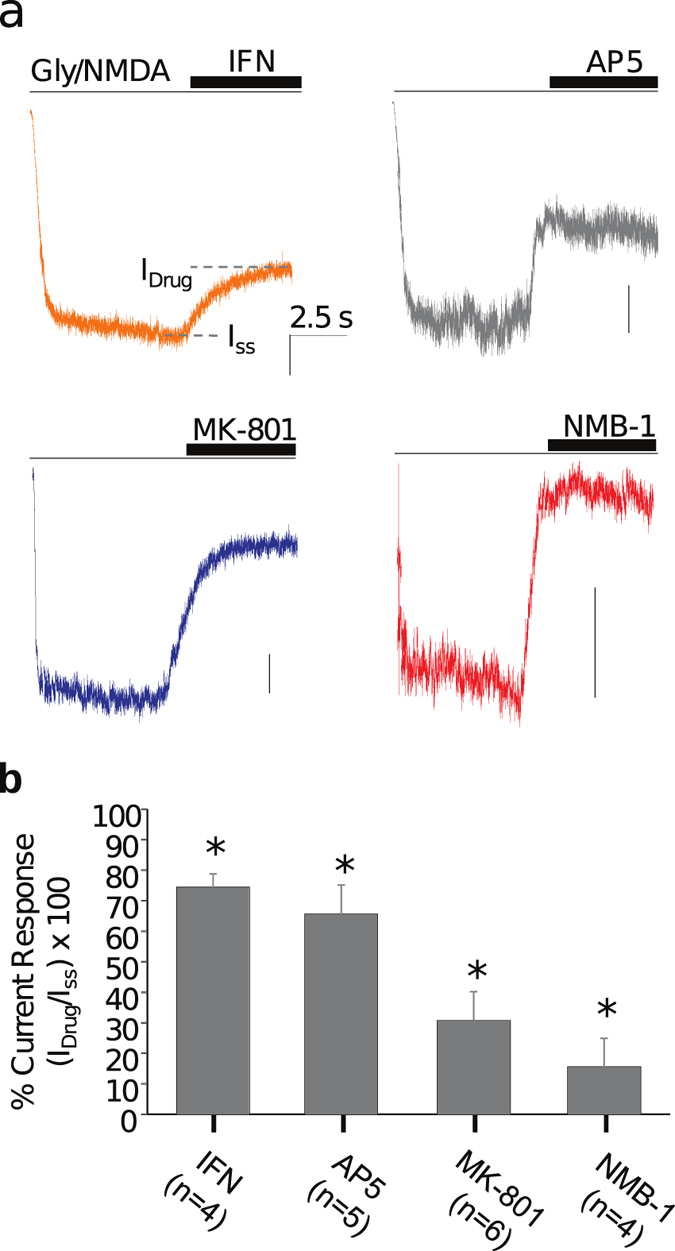
Pharmacological inhibition of NMDA-evoked currents in cultured astrocytes.(a) Representative whole-cell currents evoked by co-application of NMDA (100 μM) and glycine (100 μM); drugs were applied for 5 s to reach steady-state (Iss). Vertical scale bars represent 100 pA. (b) Summary of current blockage by IFN (10 μm, N = 4), AP5 (100 μM, N = 5), MK-801 (50 μM, N = 6), and NMB-1 (10 μM, N = 4); *Indicates significant differences relative to currents in the absence of drugs (p < 0.05).